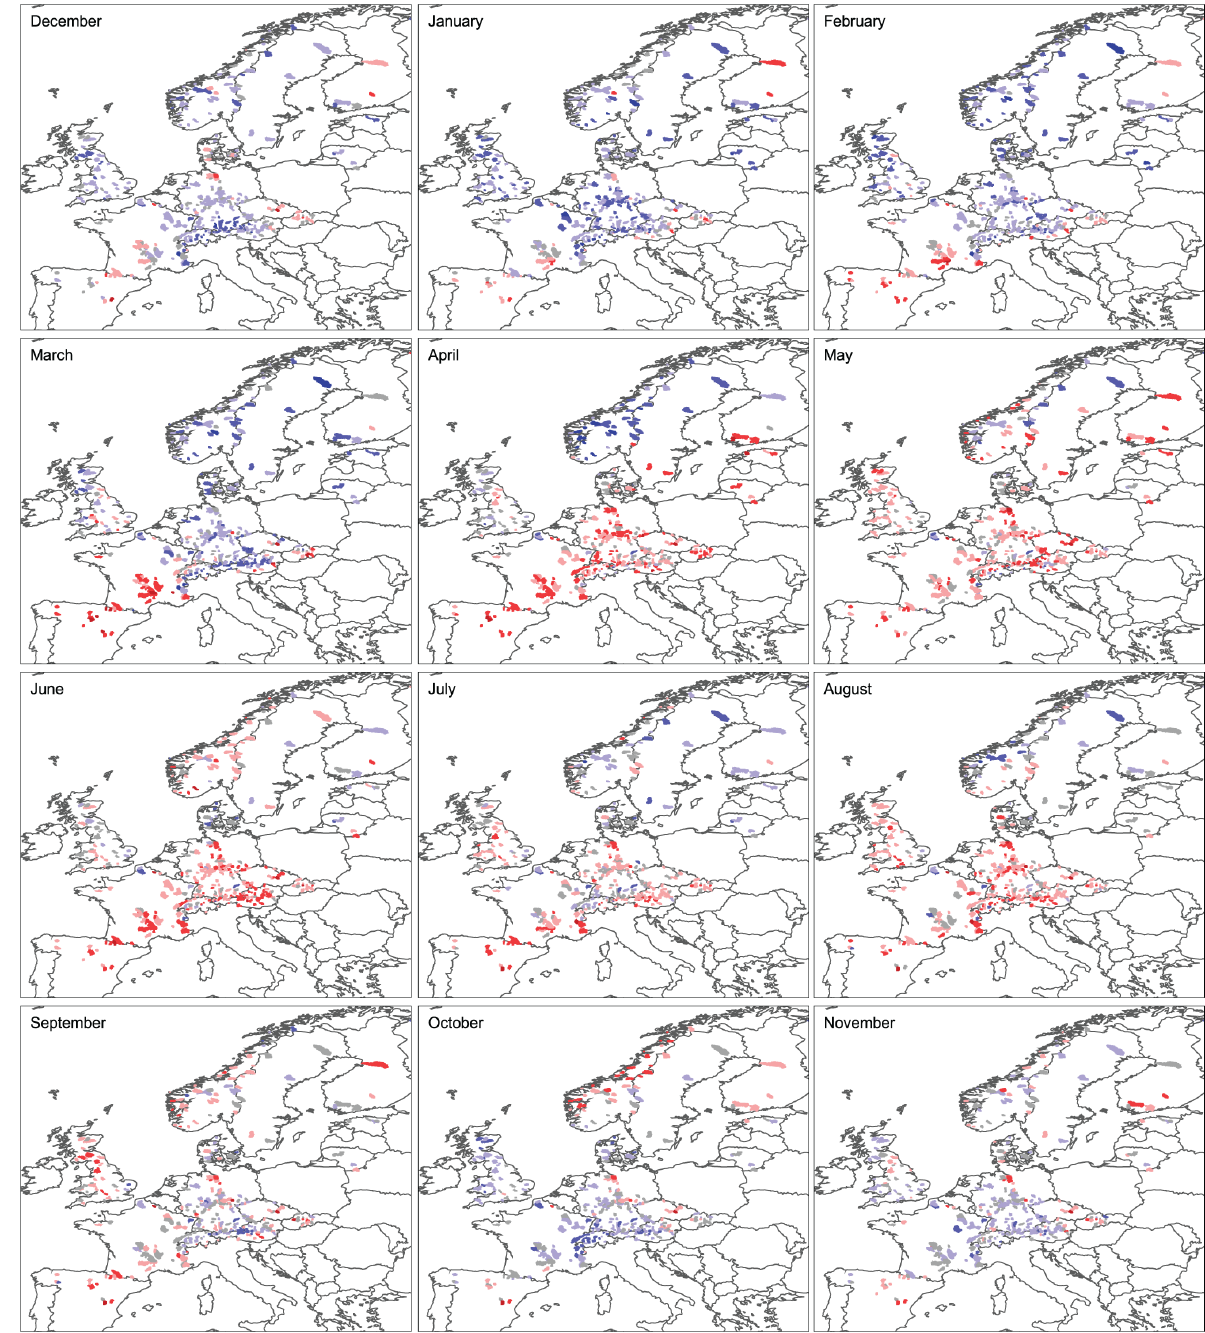
Fig. 2. Trends in monthly streamflow for the period 1962–2004 (legend as in Fig. 1).